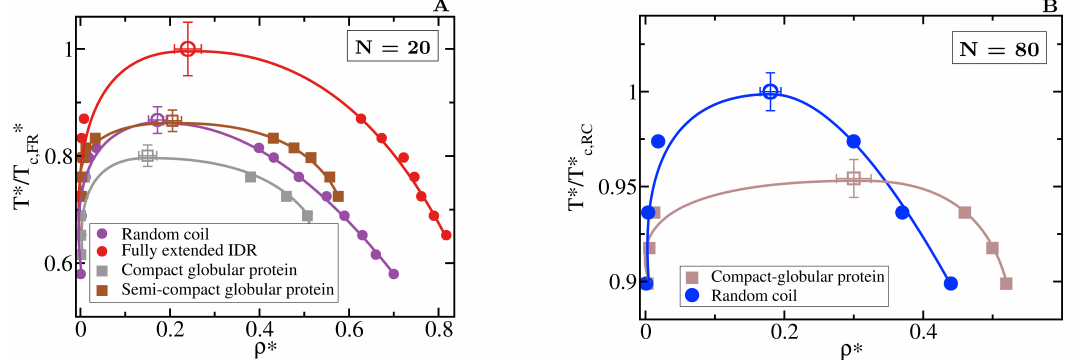
Figure 6. Role of globular and compact conformations in LLPS. ( A ) Phase diagram of different conformational ensembles of the 20-bead sequence. Results for the random coil are depicted in purple, for the fully extended IDR in red, while for the semi-compact and compact globular proteins in brown and grey, respectively. Filled circles represent the liquid coexisting densities evaluated by means of DC simulations, empty symbols the estimated critical point for each system via Equations (4) and (5), and continuous lines are included as a guide for the eye. ( B ) Phase diagram of an 80-bead fully flexible “ 0.9) (blue) and a collapsed globular conformation random coil with ă R g ą = 4.42 σ (at T ˚ { T ˚ c , RC with ă R g ą = 2.45 σ (red) of length N = 80. Note that in both panels, temperature is normalised by the critical temperature of the conformational ensemble with highest critical point for each length, T ˚ = 2.76 for the fully extended 20-bead IDR and T ˚ = 2.68 for the random coil of 80 beads. c , FE c , RC The structured globular domains for which the phase diagram is evaluated here are shown in Figure